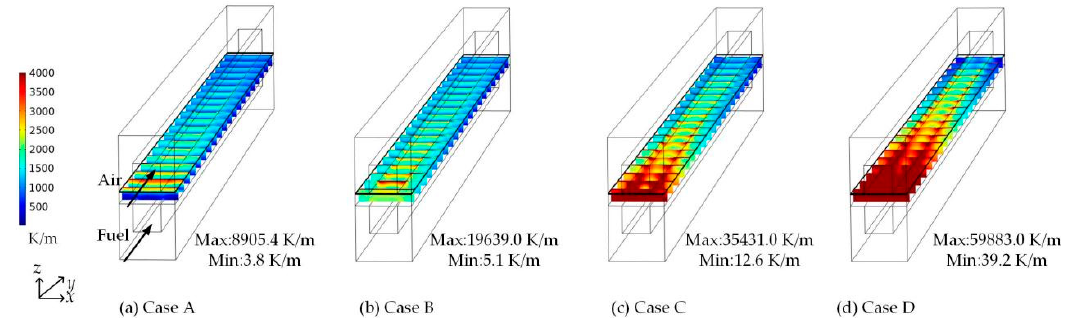
Figure 8. Distribution of the first principal stress under different methane Pre-Reforming percentages.